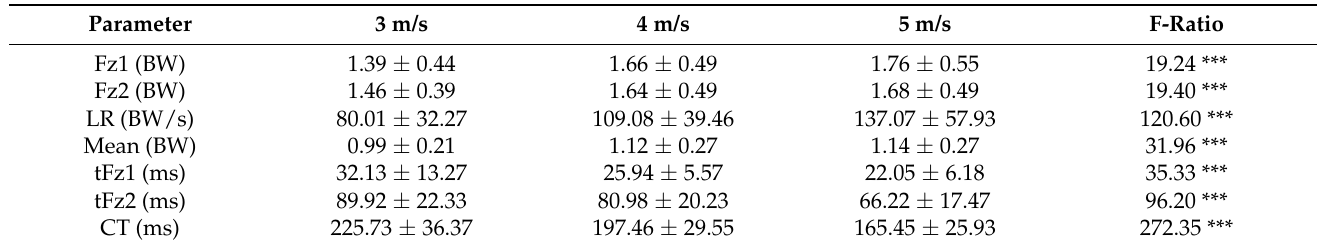
Table 3. Mean nGRF and temporal parameters for each condition and corresponding F-ratios. LR = loading rate; CT = contact time; BW = body